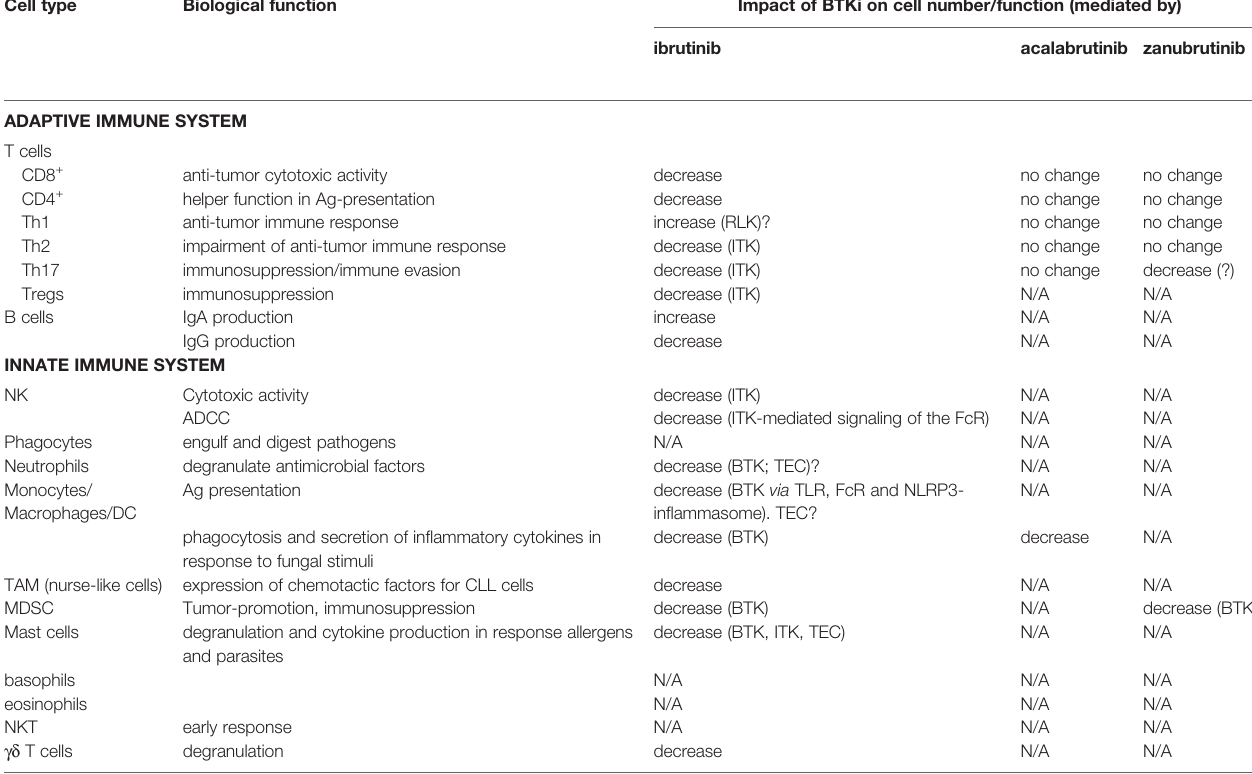
TABLE 1 | Immunomodulatory effects of BTK